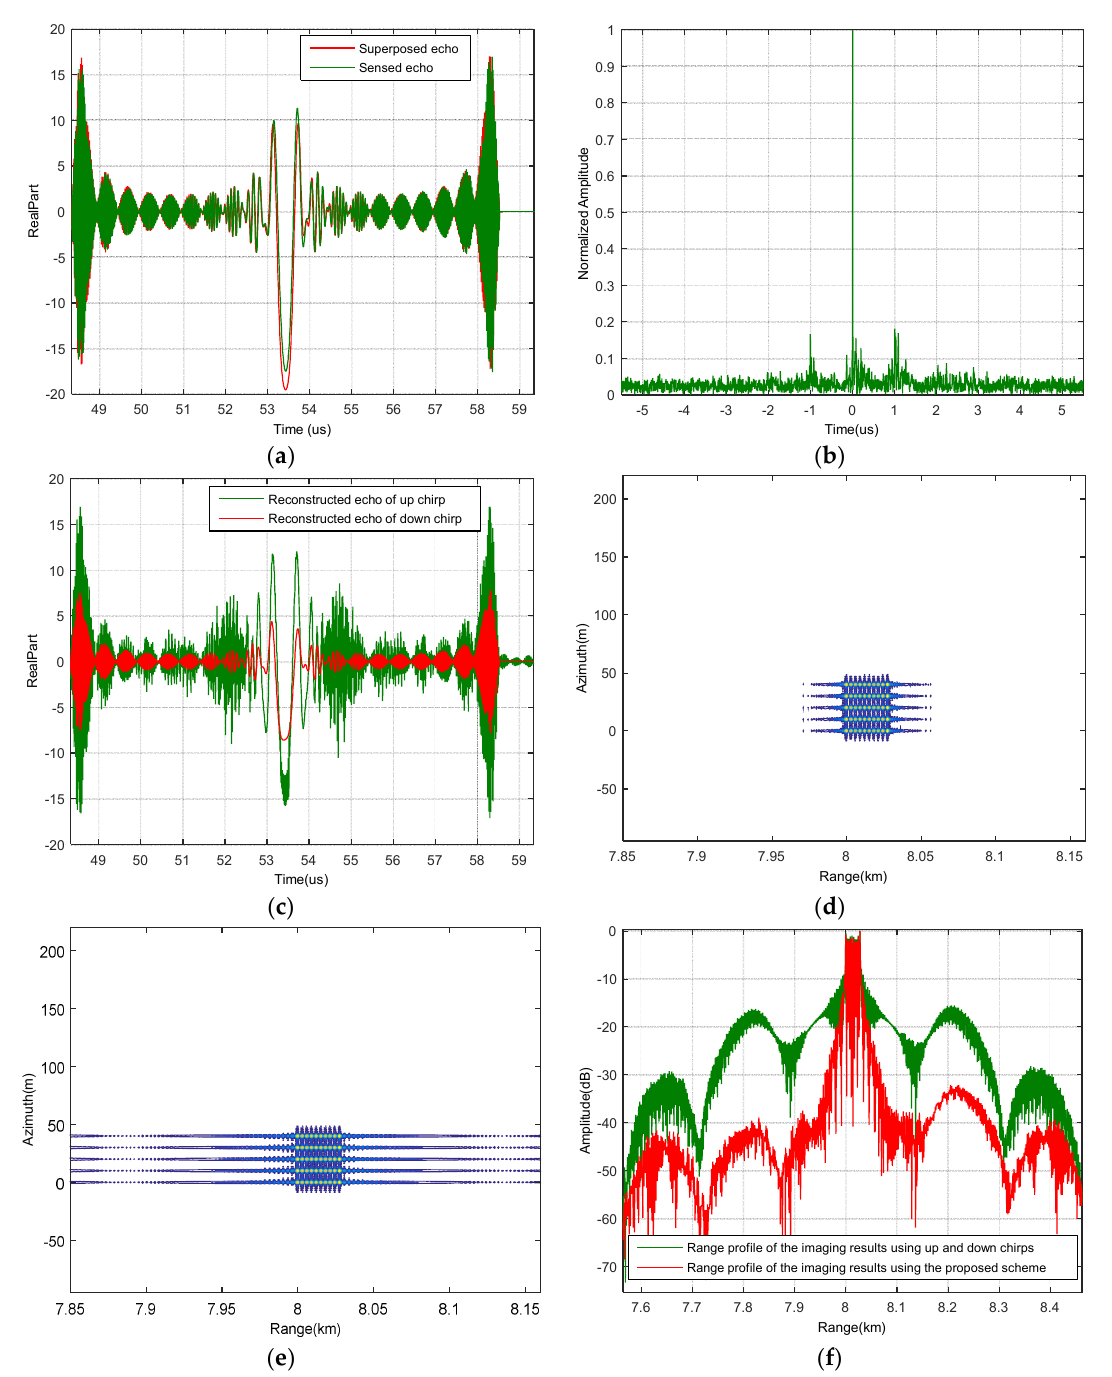
Figure 6. ( a ) The superposed echo received at the 41th azimuth position and the private echo sensed at the 60th azimuth position. ( b ) Compression result of the superposed and the sensed echoes. ( c ) Reconstructed echoes of the up and the down chirps at the 41th azimuth position. ( d ) Imaging result using all the reconstructed signals. ( e ) Imaging result using the conventional up and down chirps. ( f ) Range profiles of the imaging results shown in ( d , e ).